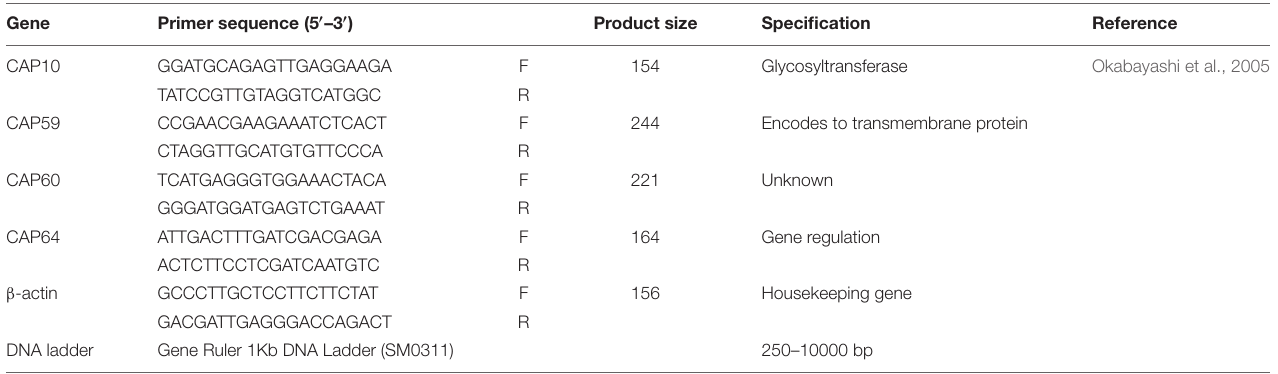
TABLE 1 | Primer used for CAP gene expression in ATCC and clinical C. neoformans. Gene Primer sequence (5 (cid:48) –3 (cid:48)